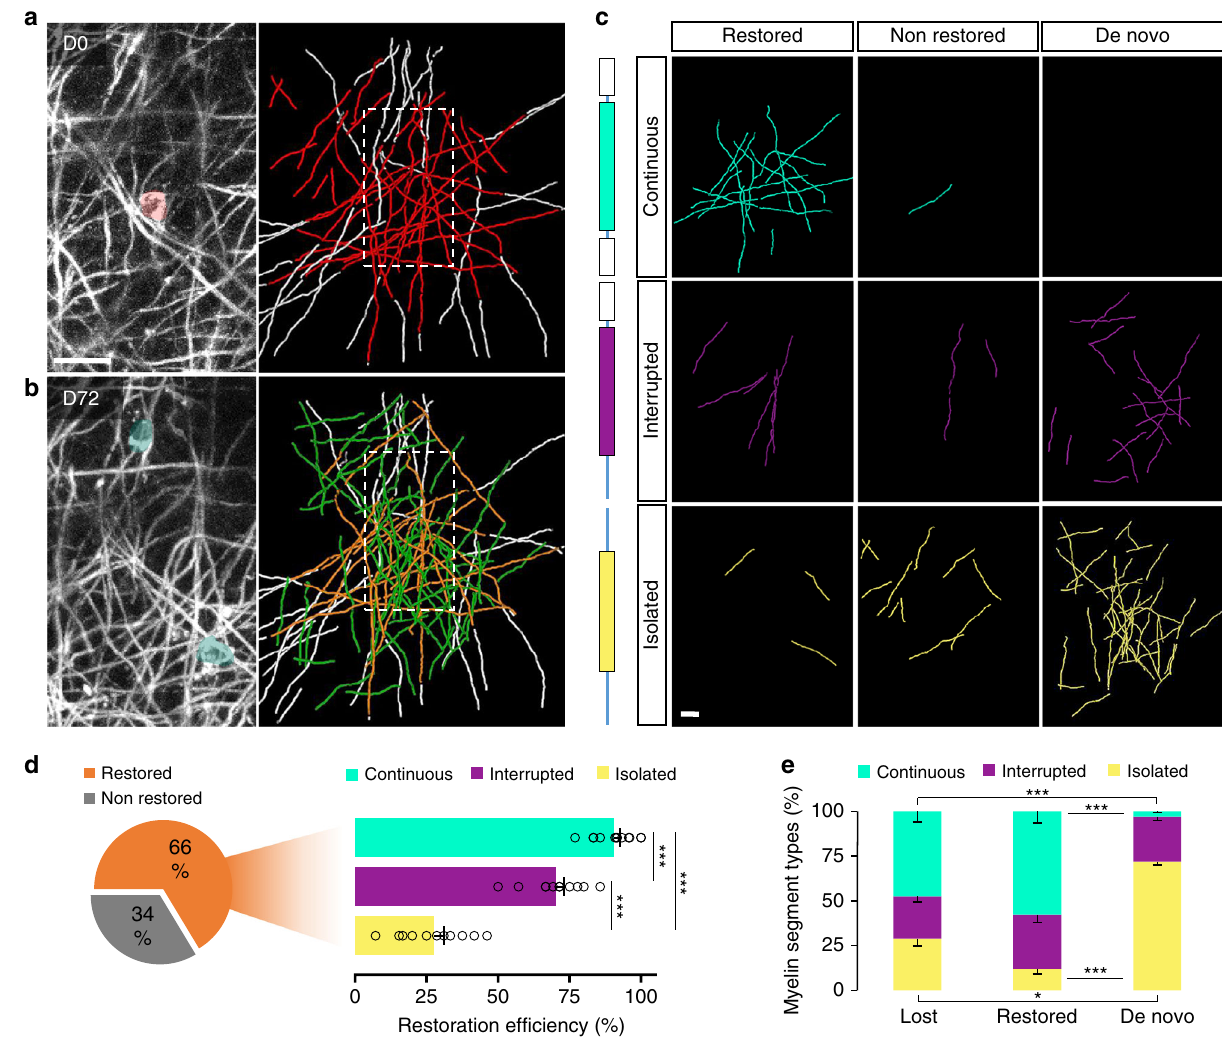
Fig. 4 Cortical remyelination ef fi cacy depends on the pre-ablation myelin patterns. a (left) Maximum projection of an OL prior to the laser ablation (in red at D0). a (right) 3D reconstruction of the lost myelin internodes between D0 and D38 (in red) and their neighboring internodes (in white). The dashed box represents the area displayed in the maximum projection. b (left) Maximum projection of a newly matured OL (in green at D72). b (right) 3D reconstruction of the gained myelin internodes between D38 and D72 (restored segments in orange and de novo segments in green) and the neighboring internodes of the lost segments between D0 and D38 (in white). The dashed box represents the area displayed in the maximum projection. Display a , b Maximum intensity projections of 30 µ m. c Traces of internodes separately displayed according to their post-ablation origin (restored, non-restored and de novo) and their pattern types (continuous, interrupted, and isolated) after single OL ablation. d Total and type-speci fi c restoration ef fi ciency from the single OL laser ablation (total: 66.4 ± 2.9%; continuous: 90.7 ± 2.1%, interrupted: 70.1 ± 3.1% and isolated: 27.5 ± 3.6%; n = 12 areas from 5 mice, mean ± SEM, one-way ANOVA with Tukey ’ s multiple comparisons test). e Internode type distribution of the lost, restored and de novo myelin fractions ( n = 12 areas from 5 mice, mean ± SEM, Kruskal – Wallis with Dunn ’ s multiple comparisons test). *** P < 0.001, * P < 0.05. Scale bar: 20 µ